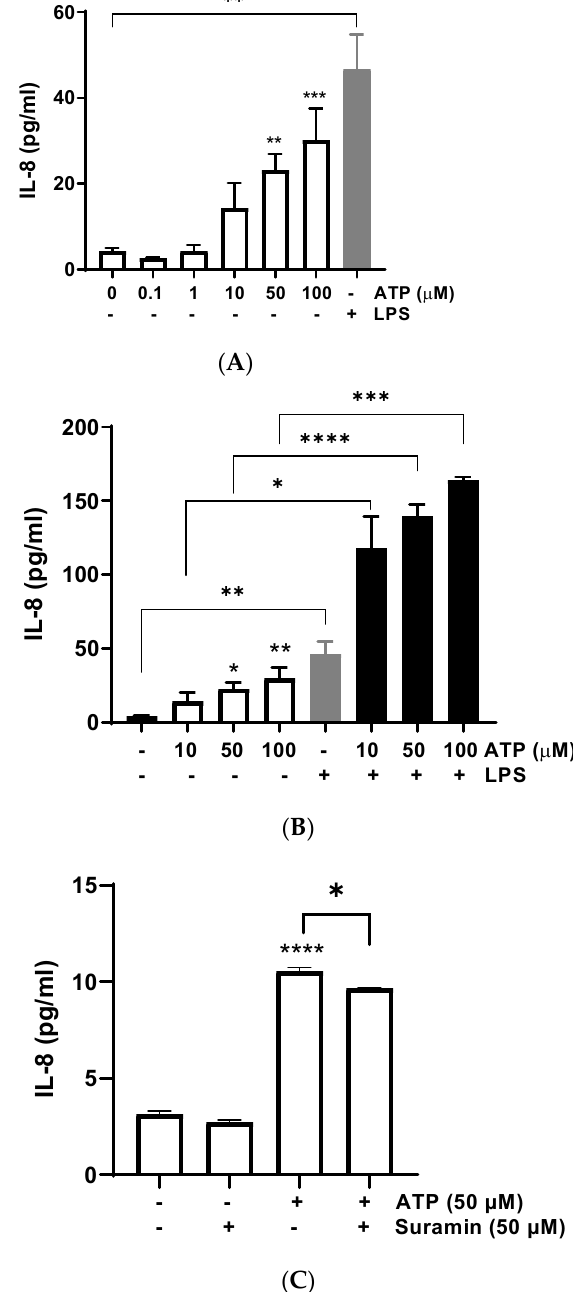
Figure 1. ATP increases interleukin-8 (IL-8) production in BEND cells. ( A ) BEND cells were treated with vehicle (PBS) or different concentrations of ATP (0.1, 1, 10, 50, and 100 μM) for 24 h, and IL-8 production was assessed in the culture medium by ELISA assay. LPS (500 ng/mL) was used as a positive control. ( B ) BEND cells were incubated with vehicle (PBS) or ATP (10, 50, and 100 μM) without or with LPS (500 ng/mL) for 24 h, and IL-8 production was assessed in the culture medium by ELISA assay. ( C ) BEND cells were incubated with vehicle (DMSO 0.1%) or suramin (50 μM) for 15 min, and then ATP (50 μM) was added for 24 h, and IL-8 production was determined by ELISA assay. n = 3 independent experiments. * p < 0.05, ** p < 0.01, *** p < 0.001, **** p < 0.0001.